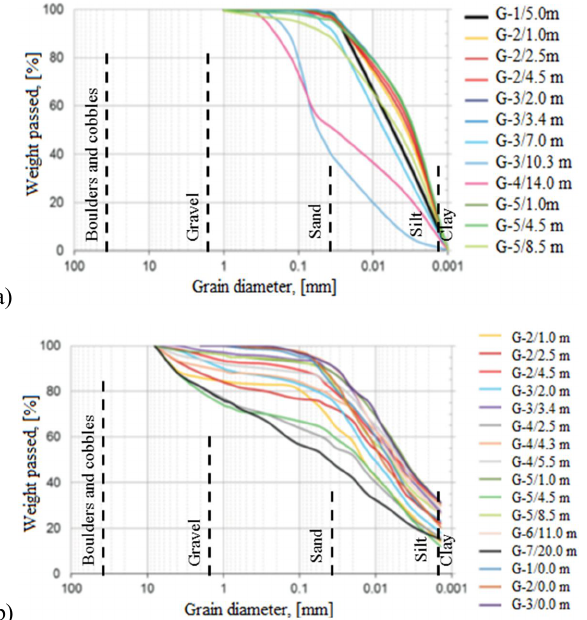
Figure 3. Results of grain-size analysis: (a) sedimentological method and (b) geotechnical method (granular classification by ISO/DIS 14688) (Benac et al., 2014 – modified by Elvis Žic).